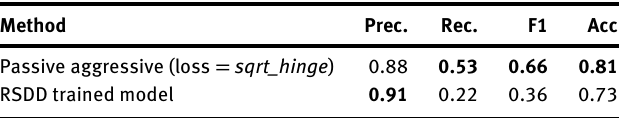
Table 7: Comparative results on classifying PPD after removing depression related words from the